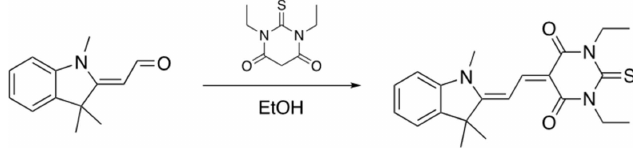
Figure 6 Synthesis of 1,3-diethyl-2-thioxo-5-(2-(1,3,3-trimethylindolin-2-yl- idene)ethylidene)dihydropyrimidine-4,6(1 H ,5 H )-dione (DTB).